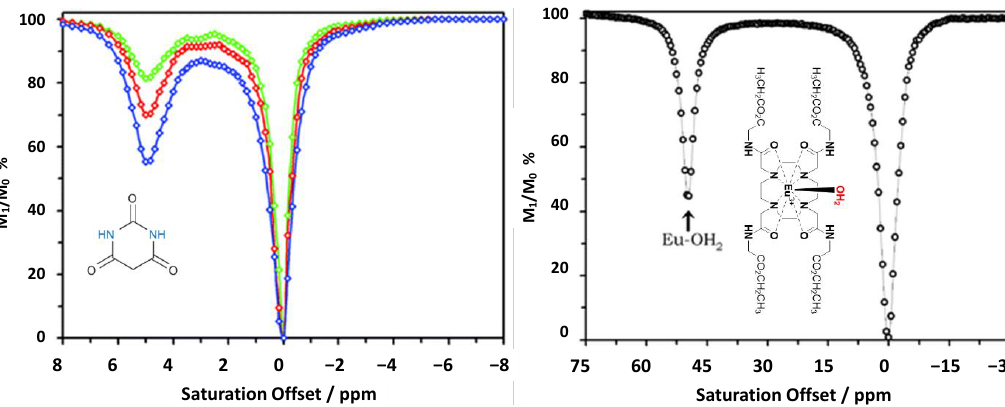
Figure 11. CEST spectra of 125 mM (blue), 62.5 mM (red), and 31.25 mM (green) solutions of barbituric acid (diaCEST agent) recorded at 300 MHz, pH 7.0 and 37 ◦ C ( left ). The CEST spectra of a 30 mM solution EuDOTA-4AmCE3+ (paraCEST agent) recorded at 270 MHz and 25 ◦ C; the peak at +50 ppm reflects exchange with the coordinated “bound” water molecule ( right ). Adapted with permission from